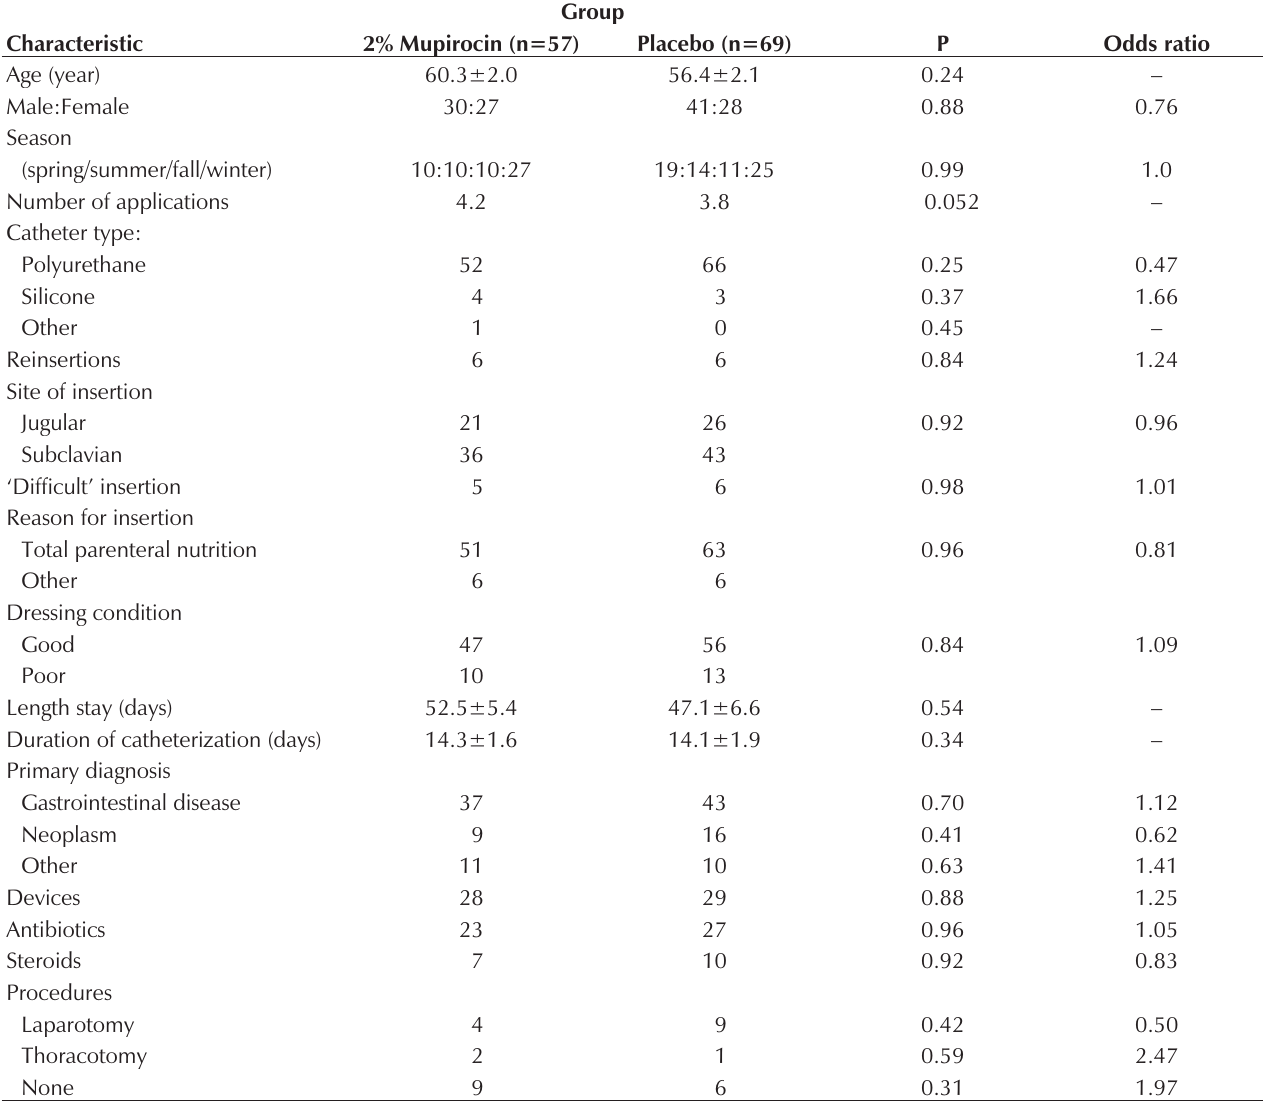
TABLE 1 Demographic features and comparability of patients with central venous catheters